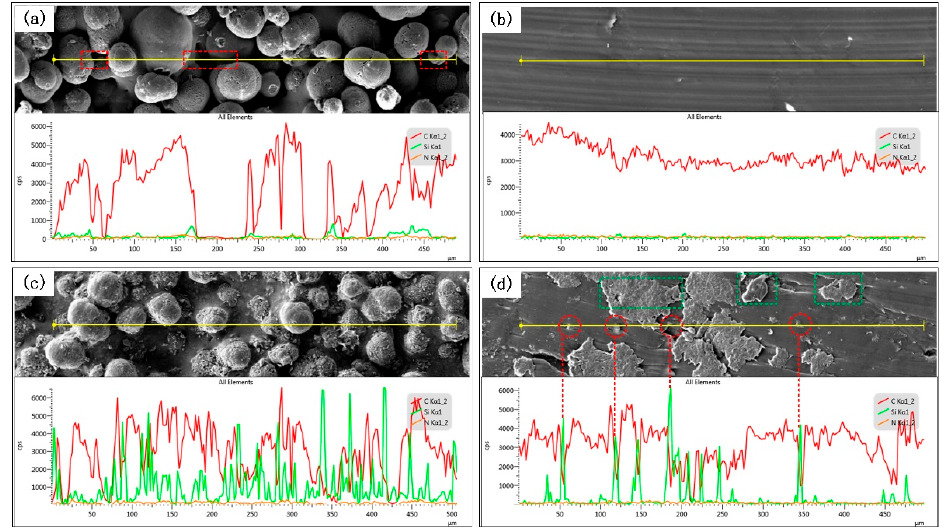
Figure 9. The SEM images and corresponding line scanning EDS analysis. ( a ) Outside of wear tracks for Pure PA 12 specimens. ( b ) Inside of wear tracks for Pure PA 12 specimens. ( c ) Outside of wear tracks for SiC/PA12 composite specimens. ( d ) Inside of wear tracks for SiC/PA12 composite specimens.